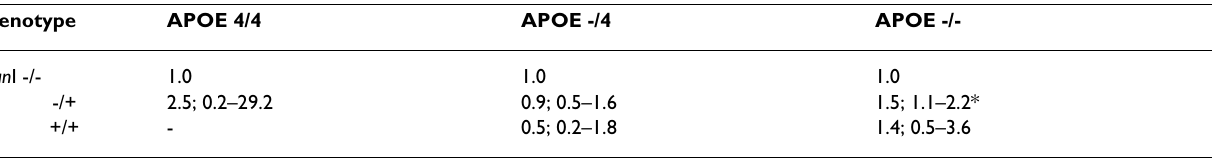
Table 3: Odds ratios for AD as a function of the TP73 exon 5 ( Ban I) polymorphism stratified by the presence or absence of APOE ε 4 alleles